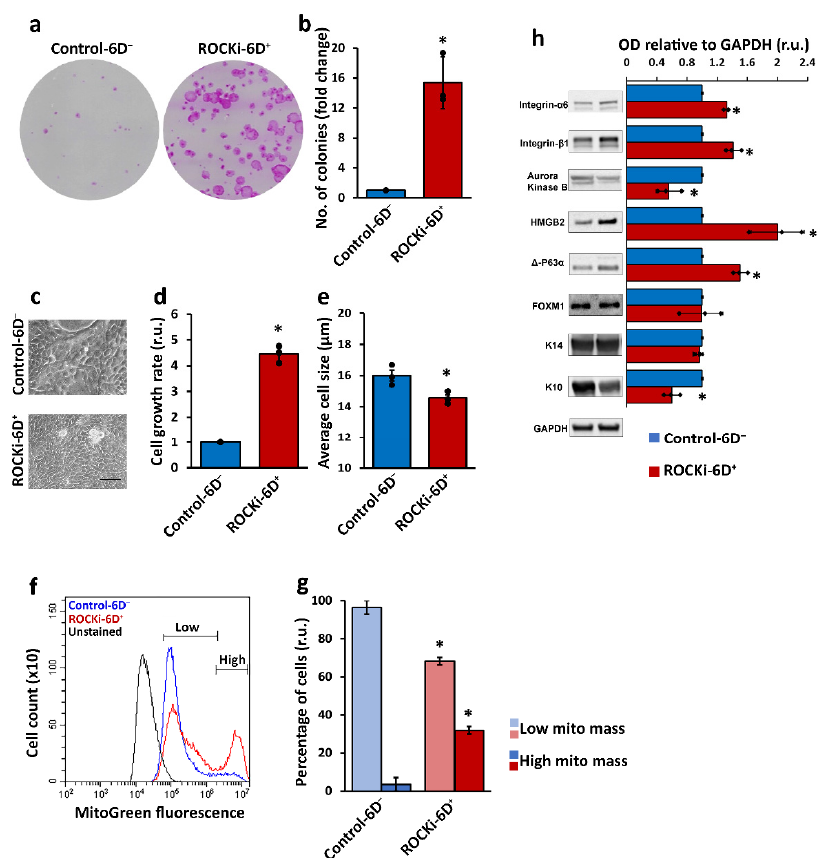
Figure 2. Six-day ROCKi treatment efficiently increased proliferation of primary keratinocytes. Primary keratinocytes at passage 0 were cultured with (ROCKi-6D + ) and without (Control-6D − ) ROCKi for six days. Colonies were stained with Rhodanile blue ( a ). A significant increase in colony formation was detected in ROCKi-treated cells (ROCKi-6D + ) compared to non-treated cells (Control- 6D − ) ( b ). The morphology of cultured keratinocytes at day 6. Scale bar = 50 mm ( c ). Increased cell growth rate in treated cells compared to non-treated cells ( d ). Decreased average cell size in treated cells compared to non-treated cells ( e ). Histogram of mitochondrial mass in treated and non-treated cells stained with 200 nM Mitotracker Green and confirmed by flow cytometry ( f ). Significant in- crease in cell populations with high mitochondrial mass in treated cells compared to non-treated cells ( g ). Left panel shows the images of representative immunoblots probed with increased prolif- eration markers and reduced differentiation marker (K10) ( h ). GAPDH was used as a loading con- trol. The right panel shows the densitometry analysis for immunoblots. Data are presented as mean ± S.D., n = 3, * = p < 0.05.